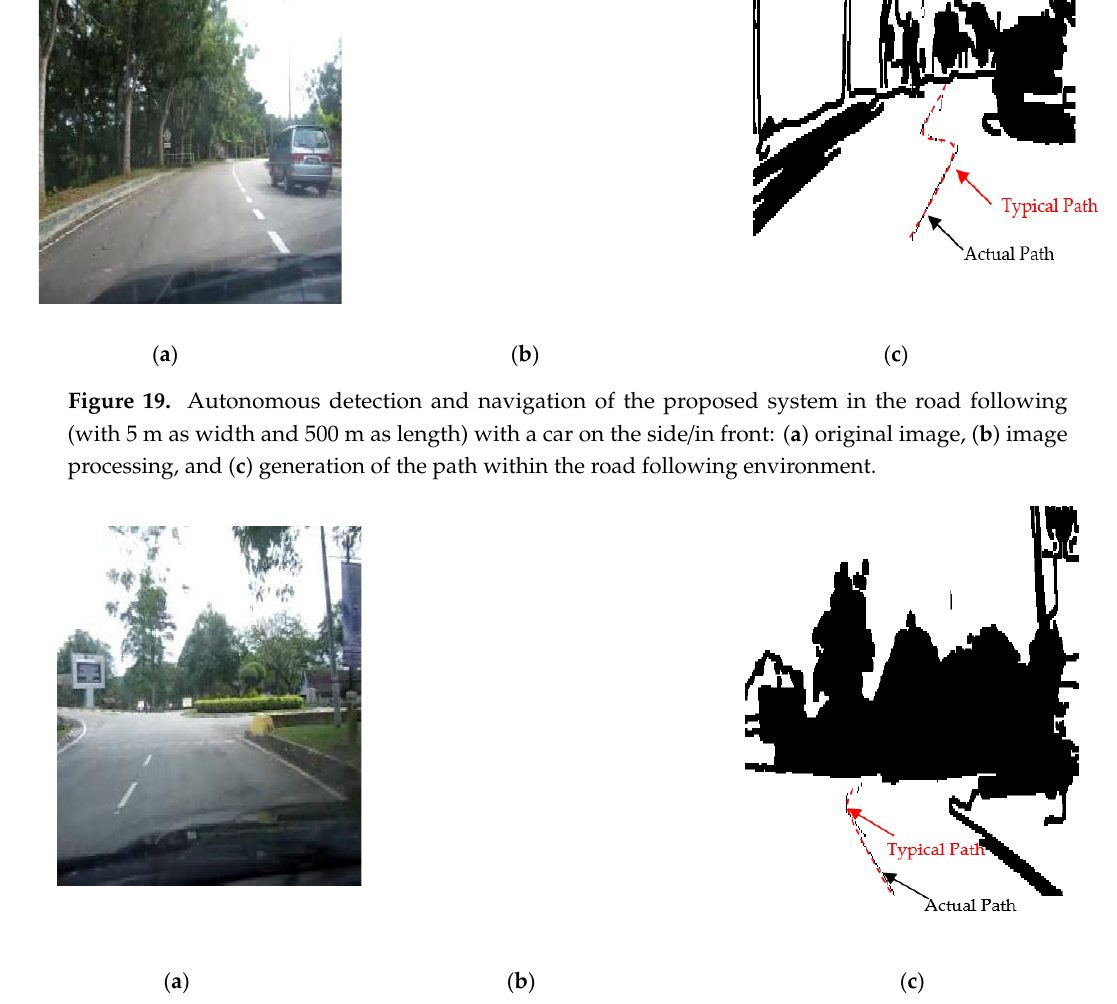
Figure 20. Autonomous detection and navigation of the proposed system in the road roundabout (with 5 m as diameter): ( a ) original image, ( b ) image processing, and ( c ) generation of the path within